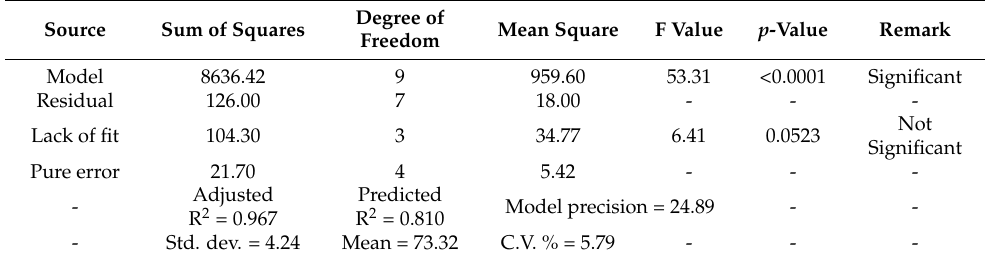
Table 6. Analysis of variance ANOVA of the second-order polynomial (Equation (2)).